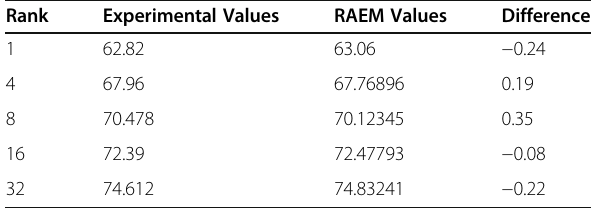
Table 3 Comparison between the experimental values and RAEM values Rank Experimental